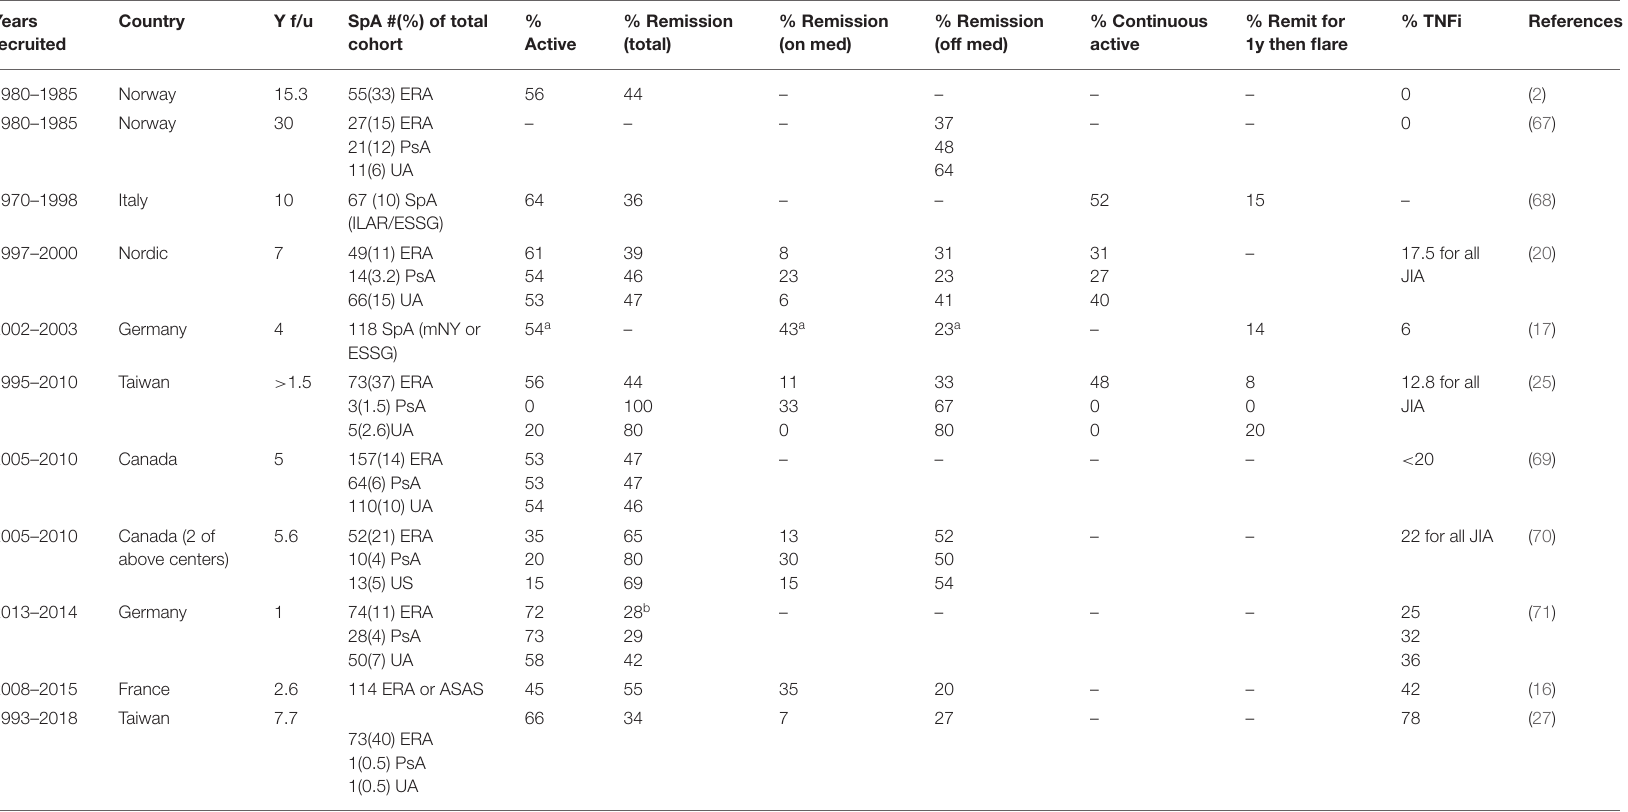
TABLE 3 | Remission vs active disease in Juvenile Spondyloarthritis